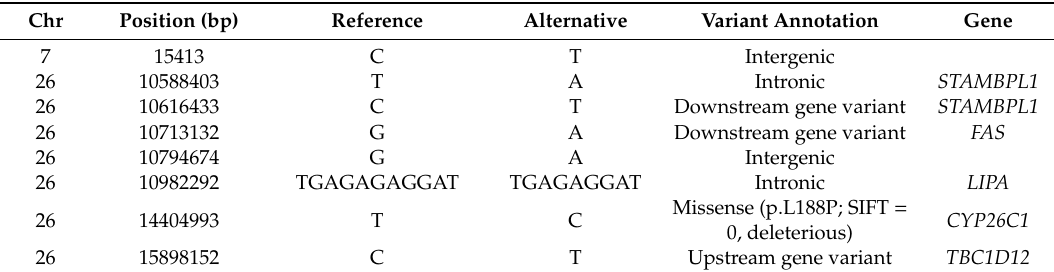
Table 2. Candidate variants identified from whole-genome sequence data. WGS included 3 a ff ected calves, 10 obligate carriers, and 7 related individuals. Variants were further filtered using WGS data from additional